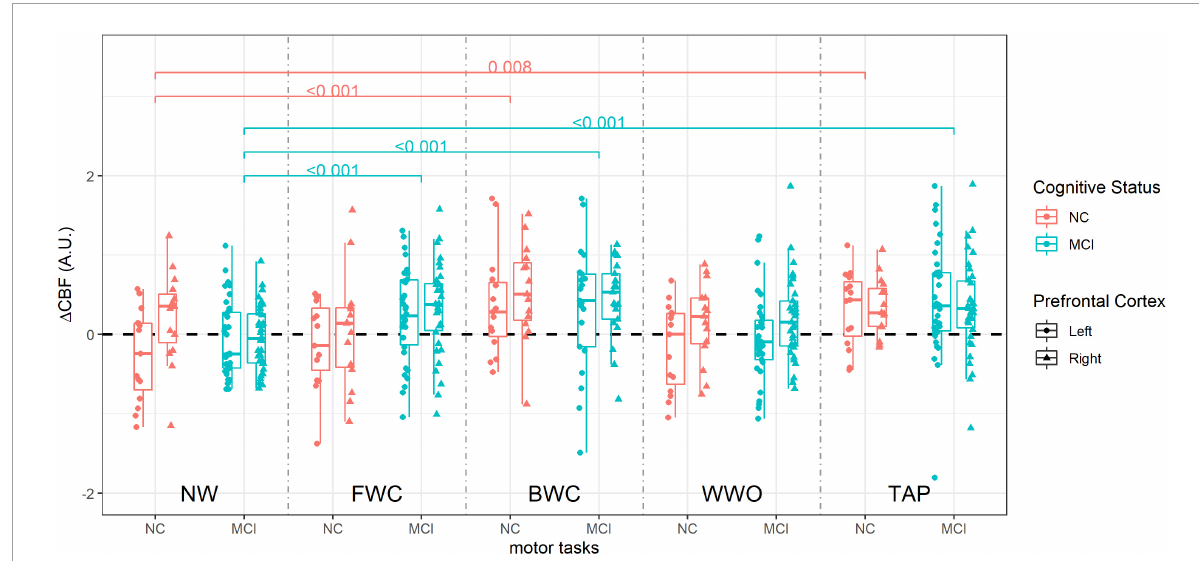
FIGURE5 Cerebral blood flow during dual-task paradigm, stratified by group (NC vs. MCI). CBF values from each side are included (right and left prefrontal cortex). P -values on brackets indicate between-task CBF comparison within the cognitive status group from the linear mixed effect model. (cid:49) CBF, cerebral blood flow change; A.U., arbitrary units; NW, normal walk; FWC, walk while 2-forward count; BWC, walk while 3-backward count; WWO, walk while negotiating obstacles; TAP, heel tapping; NC, participants with normal cognition; MCI, mild cognitive impairment.